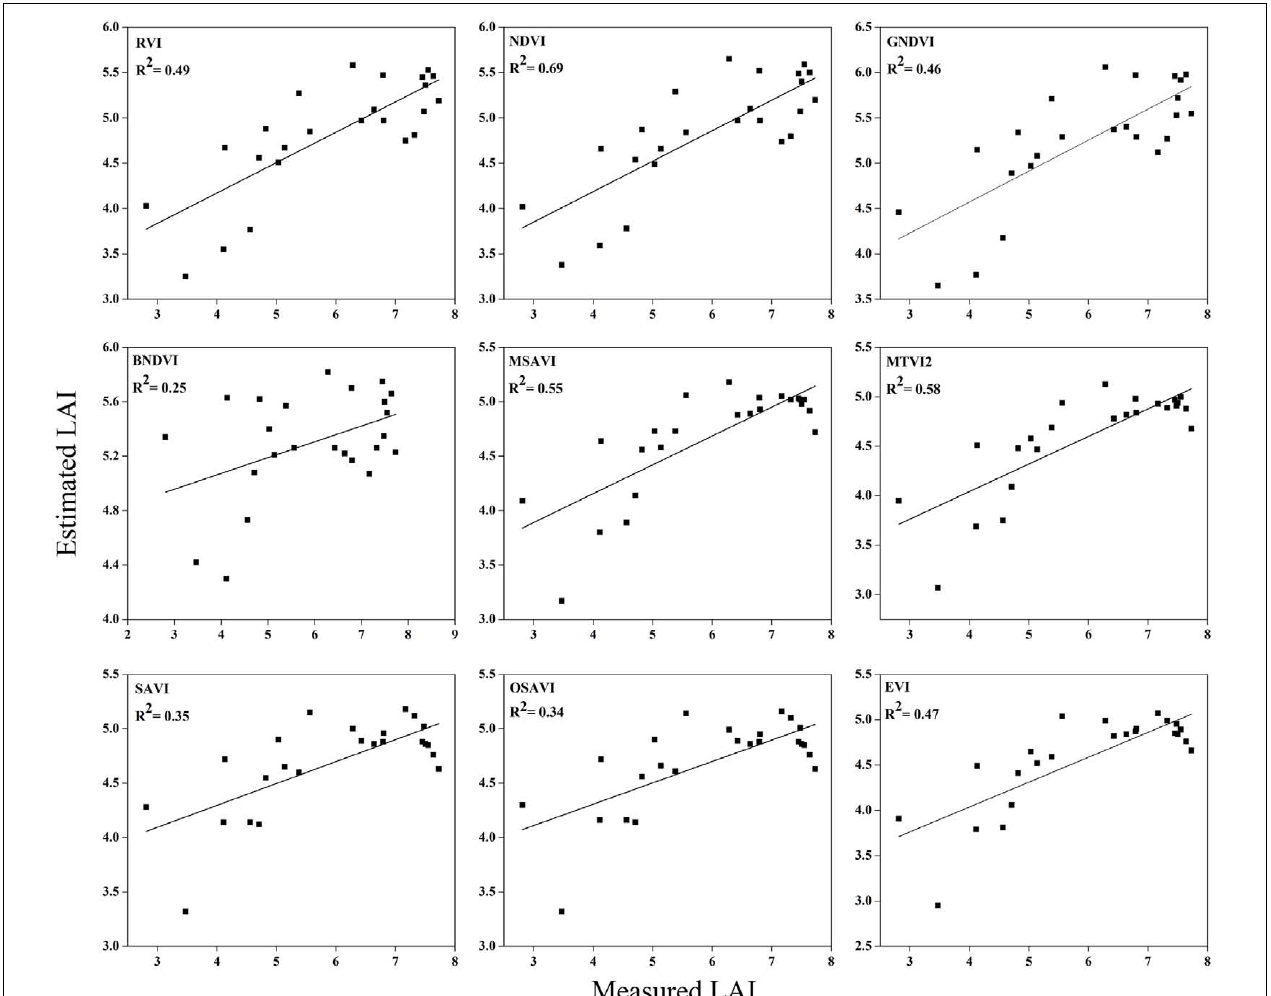
FIGURE 11 | Relationship between measured LAI and estimated LAI at